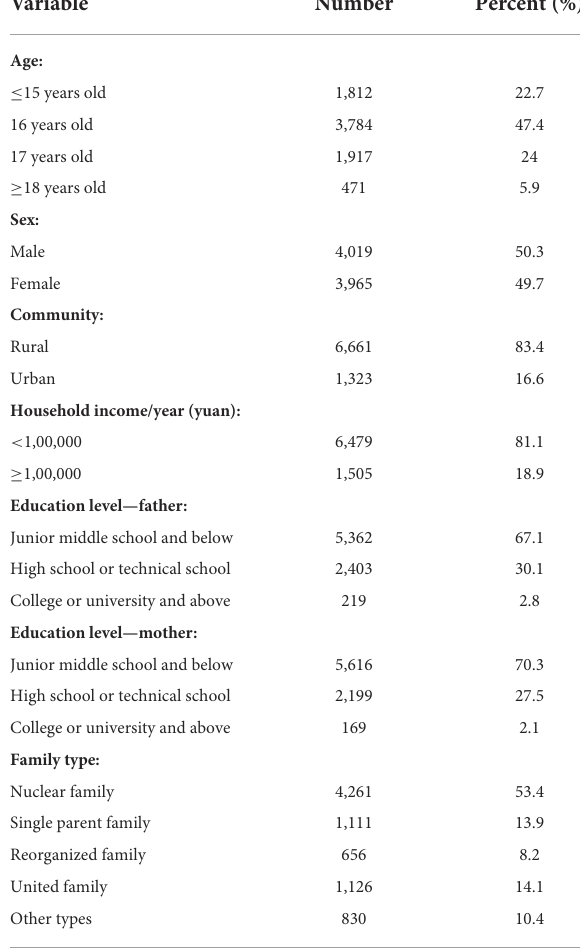
TABLE 1 Socio-demographic characteristics of